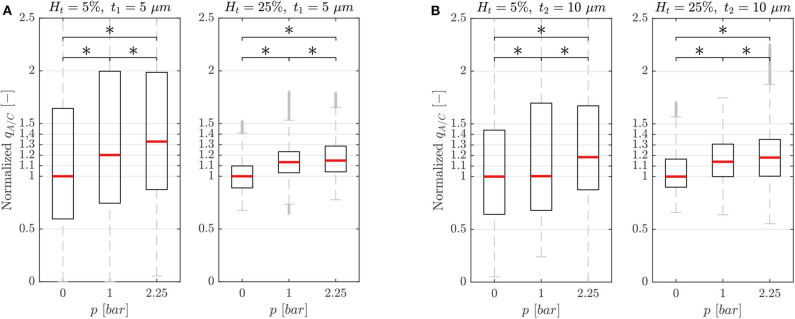
Characterization results. Characterization results for the single-mesh network with membrane thickness t1 = 5 μm
(A) and t2 = 10 μm
(B). Data were sampled from the ROIs illustrated in Figure 1 and show the RBC flux ratio between the activated and control branch in function of the hematocrit Ht and pressure p in the pressure chamber (*p-value < 0.05, boxes indicate the 25th and 75th percentiles; red lines: median values; gray + are outliers). The RBC flux ratios in each subplot have been normalized with respect to the median value of the respective RBC flux ratio at p = 0 bar.